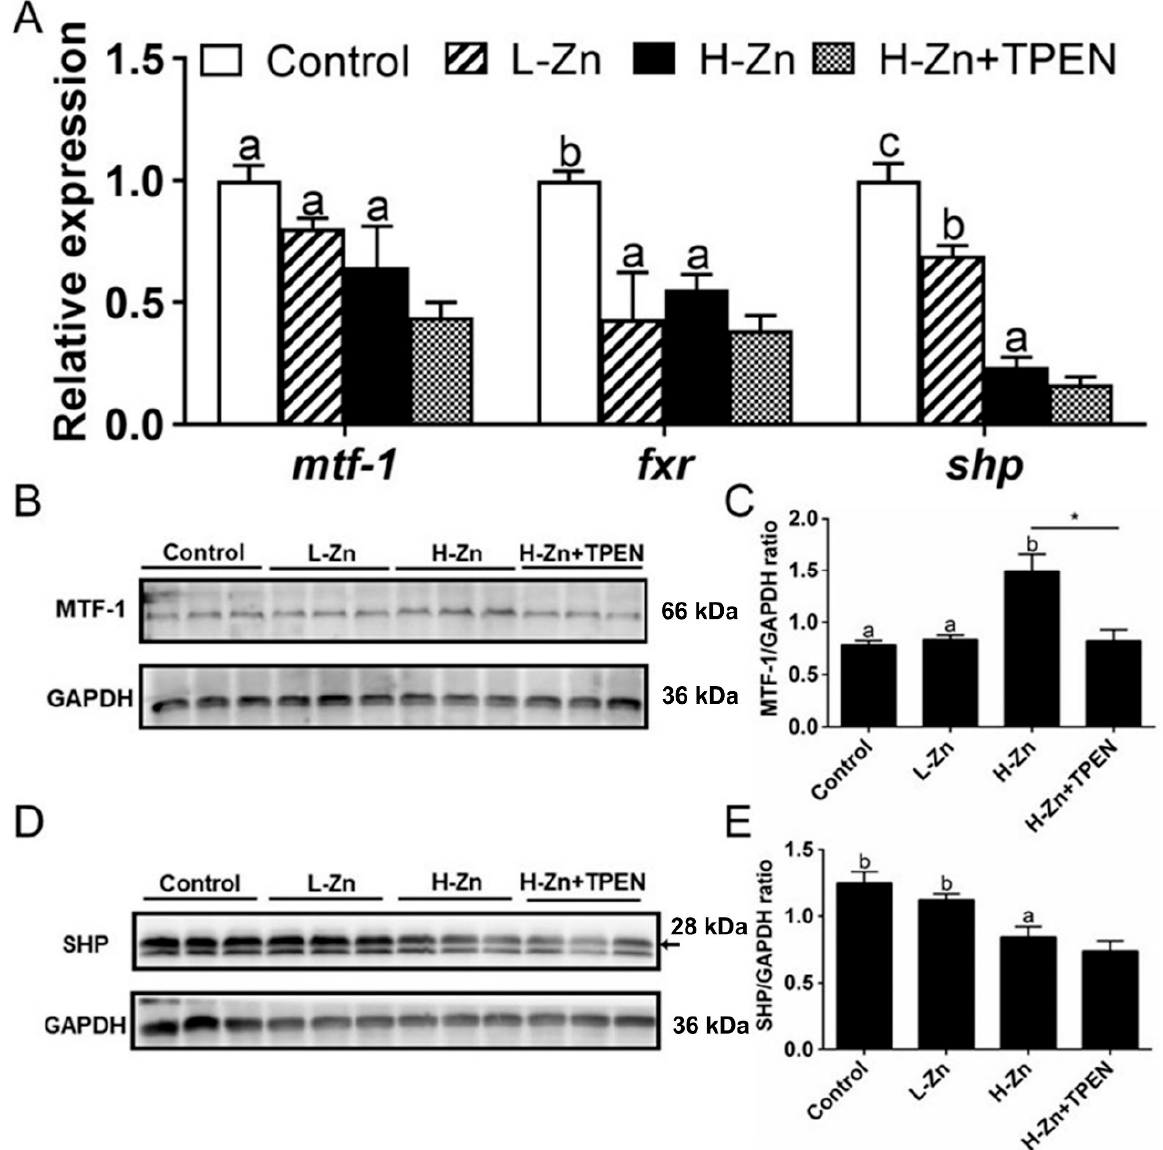
Figure 4. Effects of nano-sized zinc oxide on MTF-1-SHP pathway genes. ( A ) The mRNA levels of MTF-1-SHP pathway genes. ( B ) MTF-1 protein level. ( C ) Quantification of the MTF-1 protein level. ( D ) Protein levels of SHP. ( E ) Quantification of SHP protein level. L-Zn: low dietary Zn; H-Zn: high dietary Zn; H-Zn + TPEN: high dietary Zn + TPEN. Different letters indicate the significant differences among the three dietary Zn levels ( p < 0.05 ). Asterisks (*) indicate significant differences between 100 mg/kg nano-ZnO and the 100 mg/kg nano-ZnO + TPEN group ( p < 0.05). For each value, three biological replicates are undertaken.